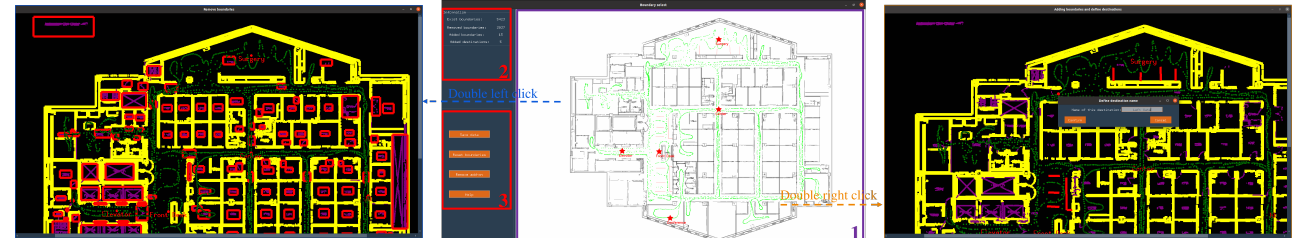
Figure 5. Boundary/destination GUI. The main window is displayed in the middle . It comprises three zones. The green dots in Zone 1 depict the locations of database images, while the red star indicates potential destinations. After double-clicking Zone 1 , map-makers can adjust boundaries and desired destinations in additional pop-up windows ( left and right ). After double left-clicking Zone 1 , the map-maker can delete boundaries in the pop-up window ( left ) by removing line segments (which represent boundaries) using an edit tool (red superimposed box). After double right-clicking Zone 1 , another pop-up window ( right ) will appear, in which the map-maker can draw red lines to represent additional boundaries and define potential destinations by clicking green dots and assigning destination names to them. Additionally, boundaries and destination information are provided in the Zone 2 ( middle ). Once all the boundaries and destinations are defined, the map can be saved in Zone 3